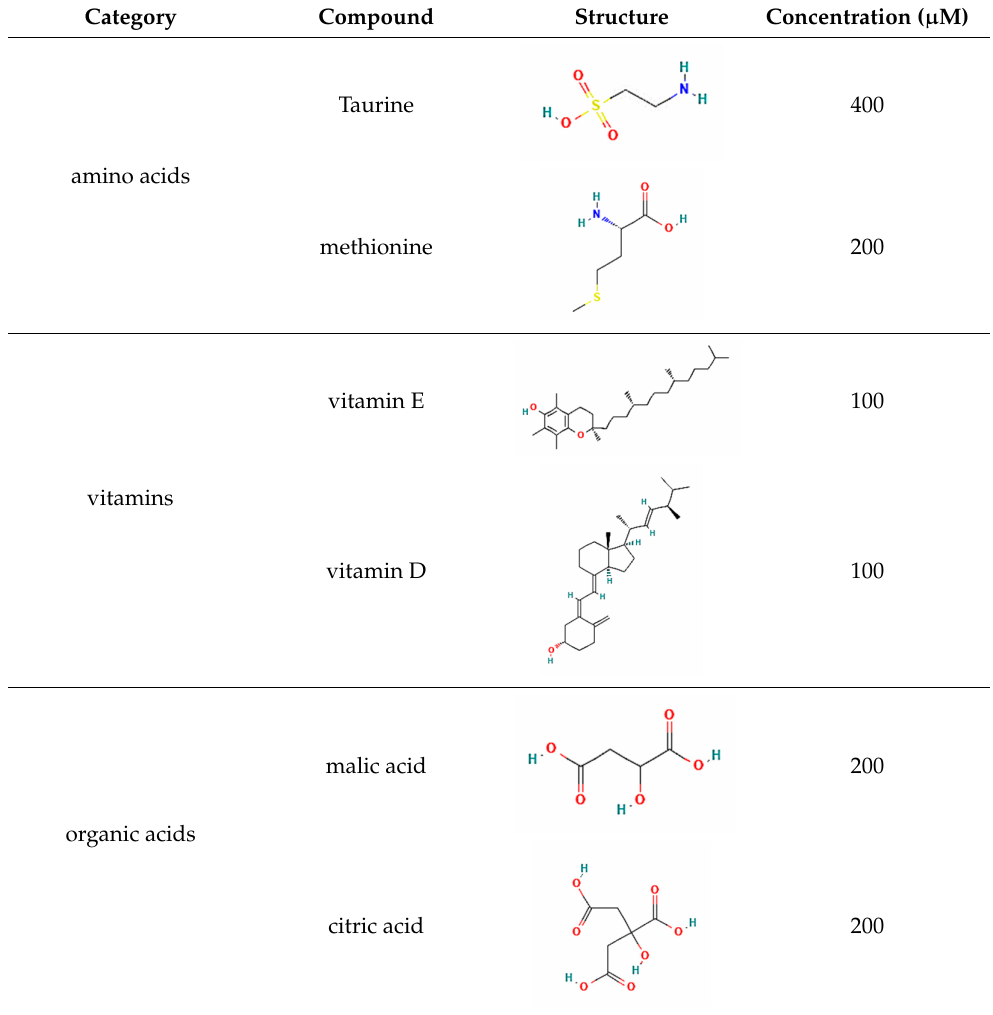
Table 1. The concentration and structure of active compounds used in this